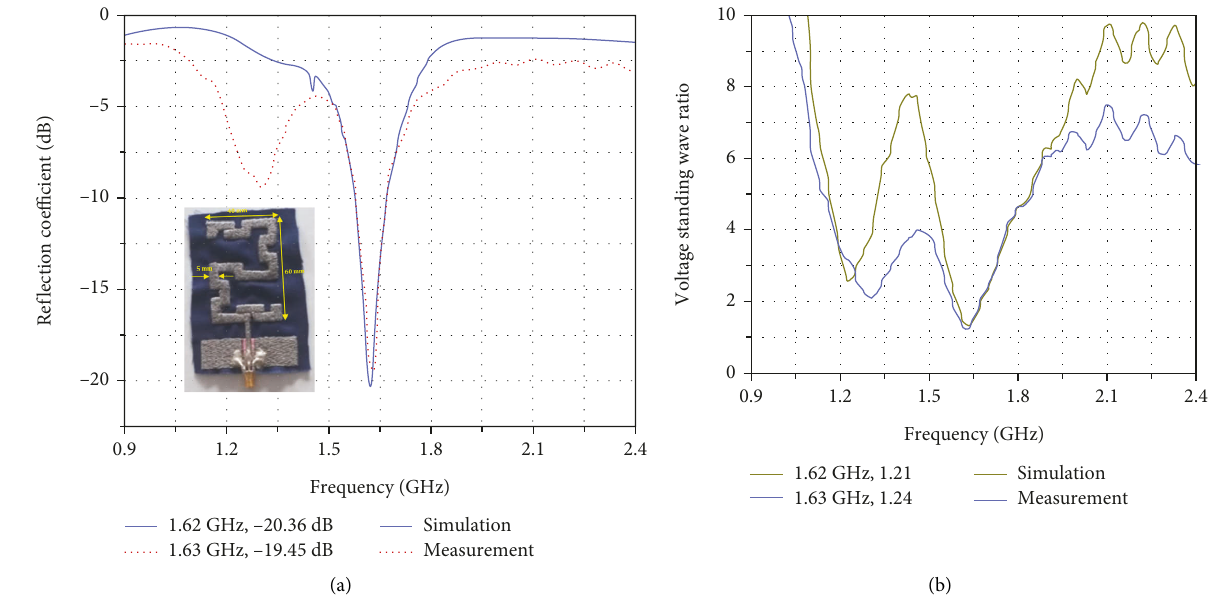
Figure 6: Simulated and measured (a) return loss and (b) VSWR plot for the textile